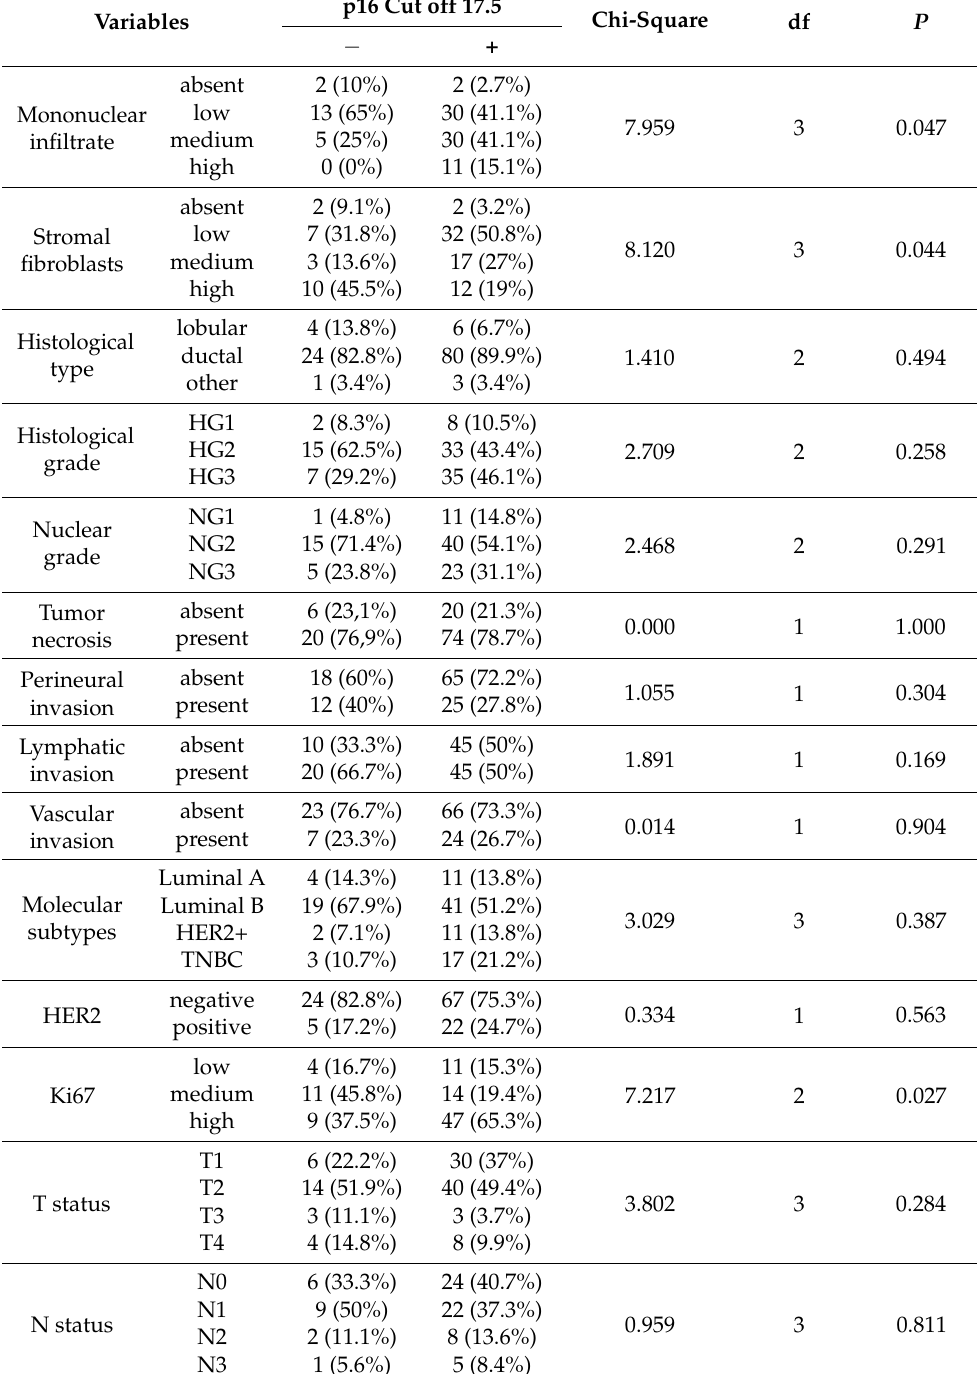
Table 3. Association between p16 expression in IBC and examined clinicopathological